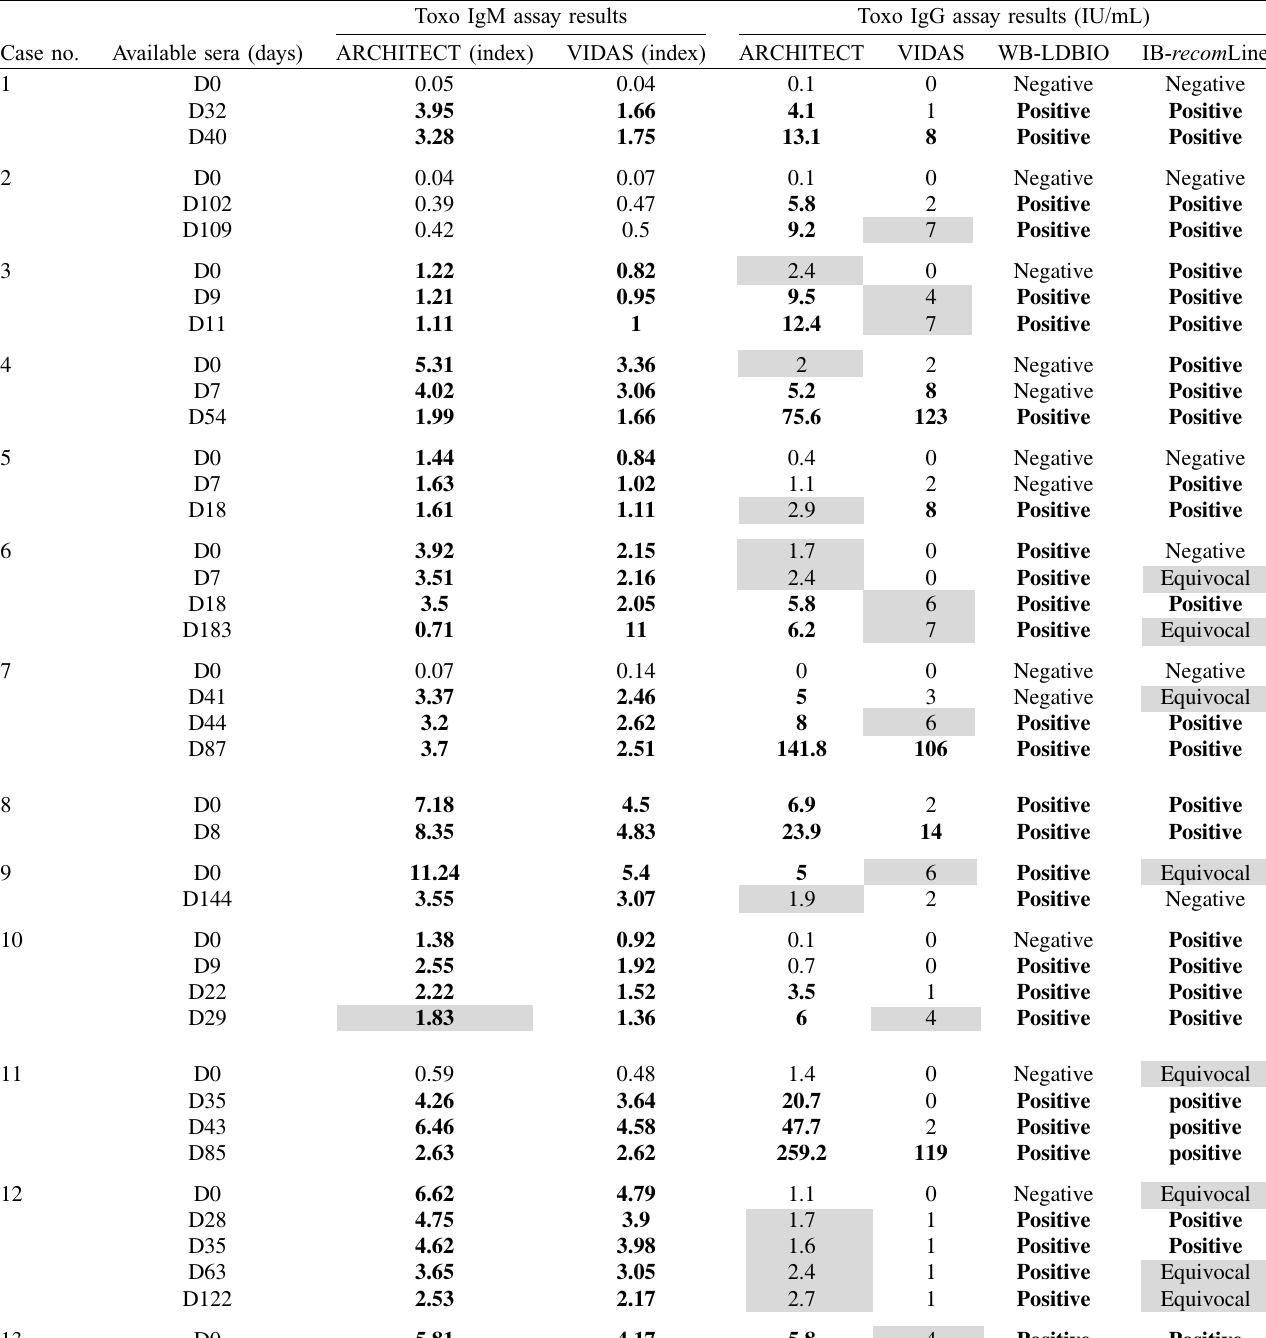
Table 3. Antibody kinetics (IgM and IgG) in 13 cases of women with proven seroconversion. Toxo IgM assay results Toxo IgG assay results (IU/mL) Case no. Available sera (days) ARCHITECT